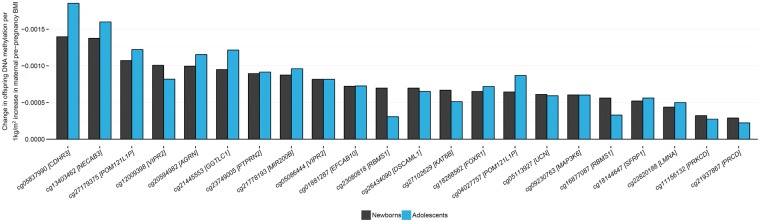
Comparison of estimates of the effect of maternal BMI on offspring DNA methylation at birth and at adolescence. Of the 86 sites where maternal BMI at the start of pregnancy was associated with newborn blood methylation, 72 had the same direction of association in the analysis of adolescents. Plotted here are the 22/86 methylation sites with a P-value < 0.05 in the analysis of adolescents, ordered by effect size in newborns.